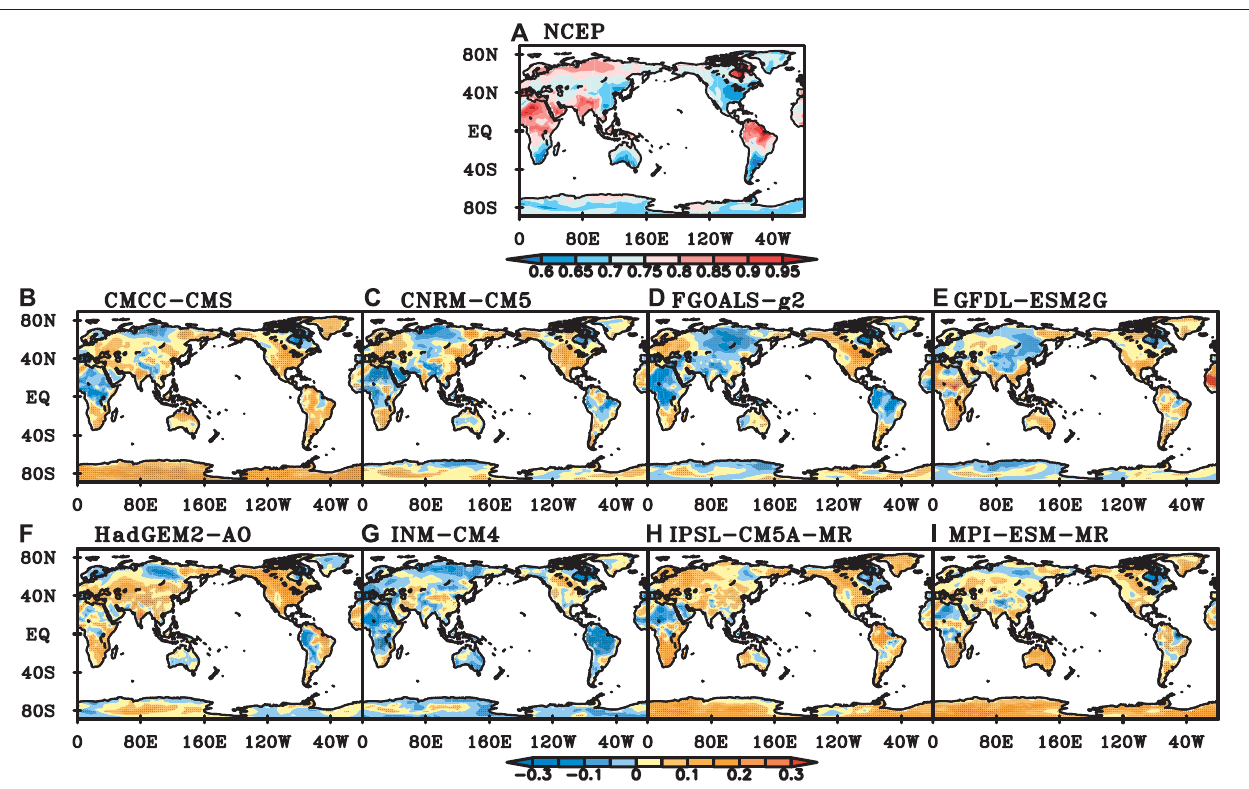
FIGURE9| ScalingexponentsofNCEPSAT (A) anddifferencebetweenNCEPandthoseofSATsimulatedby (B) CMCC-CMS, (C) CNRM-CM5, (D) FGOALS-g2, (E) GFDL-ESM2G, (F) HadGEM-AO, (G) INM-CM4, (H) IPSL-CM5A-MR, (I) MPI-ESM-MR inautumn. (Black dot represents the difference issigni fi cantat asigni fi cance level of